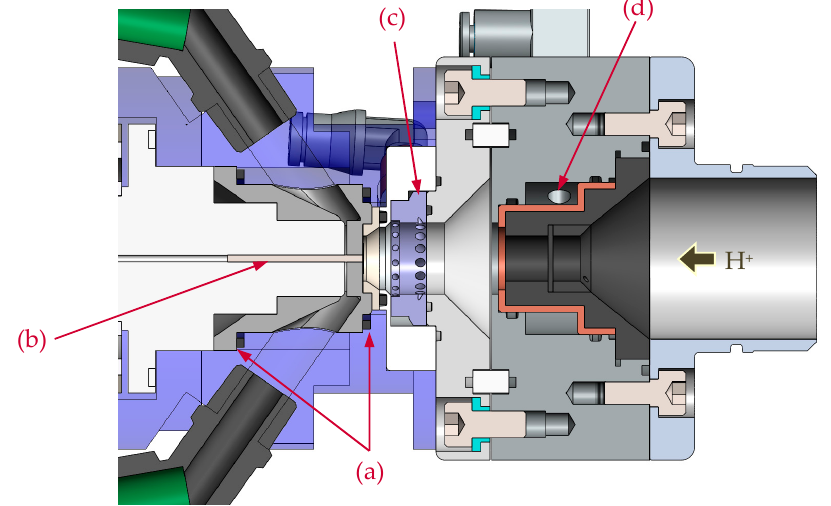
Figure 3. Details of 3D-printed sterling silver target (SS925) showing cooling and O-ring seals: (a) O-ring seals; (b) type-K thermocouple; (c) He cooling for target material and vacuum window; (d) water jacket for graphite collimator and degrader.